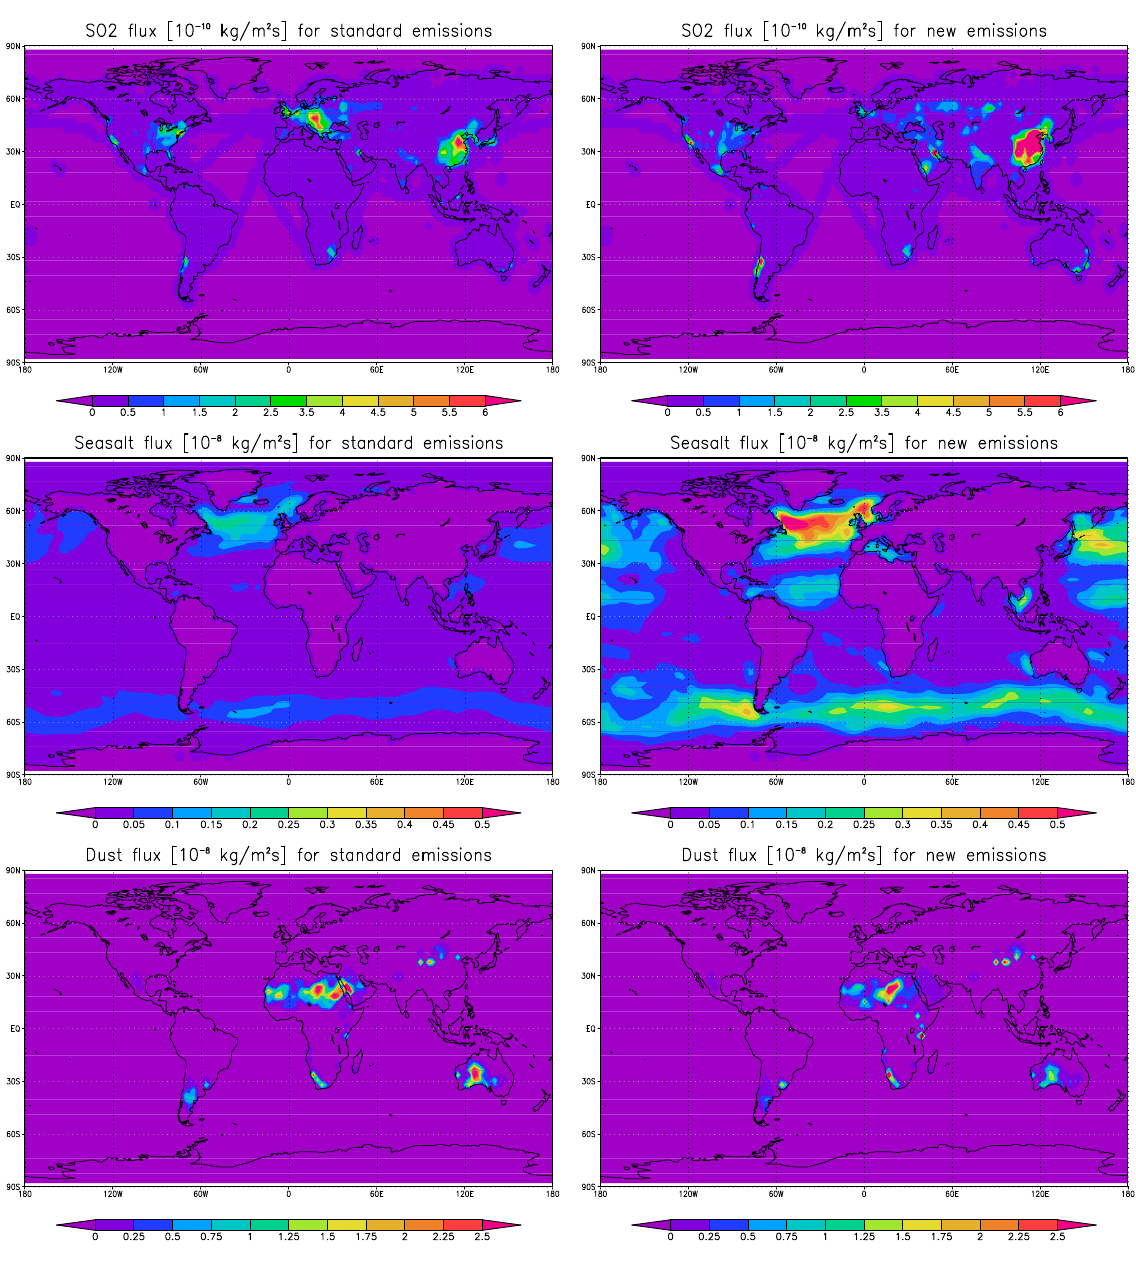
Figure 9. Global SO2, sea salt emission and dust emission (averaged over 9–30 January) for forecast runs with either the standard or new